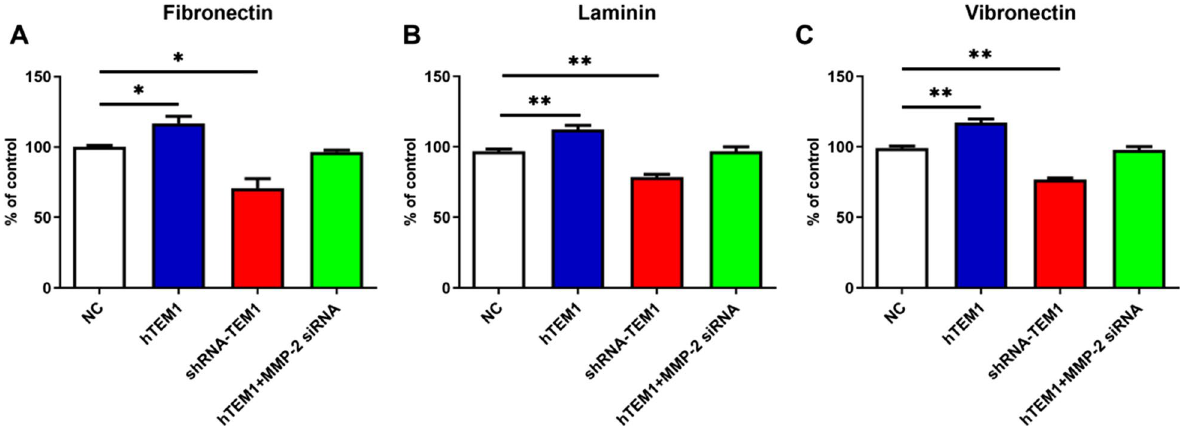
Fig. 4 TEM1 promoted MES-SA cell adhesion to extracellular matrix (ECM) via MMP-2. NC, hTEM1, shRNA-TEM1, and hTEM1 + MMP-2 siRNA cells were selected to adhere to fibronectin (Fn) A , laminin (Laminin) B , and Vitronectin (Vn) C in the ECM-coated 12-well plate for 72 h respectively. The numbers of adhesion cells were calculated based on the CCK-8 assay. *, P < 0.05; **, P < 0.01. All assays were replicated three times in